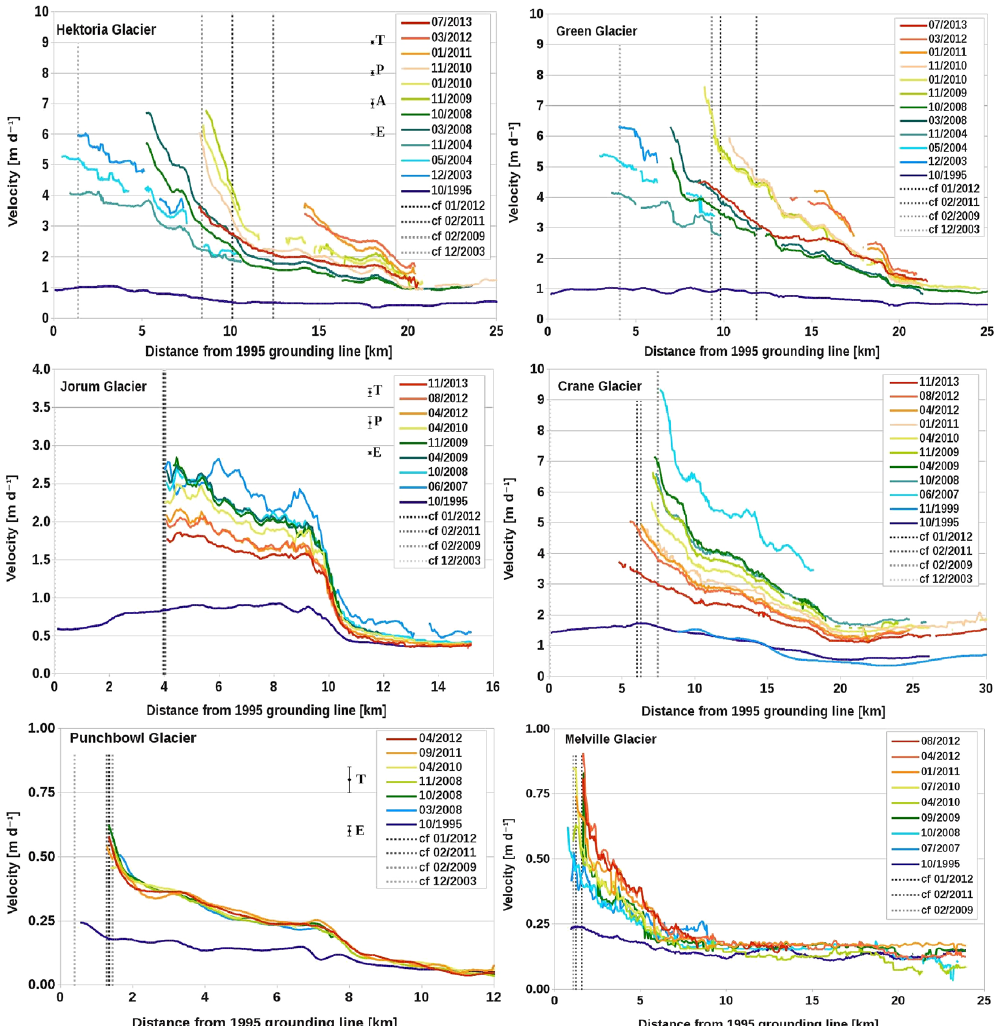
Figure 3. Surface velocities along the central flow line of Hektoria, Green, Jorum, Crane, Punchbowl and Melville glaciers and their frontal positions at different dates (month/year). The x and y scales are different for individual glaciers. Vertical lines show positions of calving front. The vertical bars show uncertainties in velocity for TerraSAR-X (T) 2007 to 2013; PALSAR (P), November 2009; ASAR (A) 2003, 2004; ERS (E) 1995,